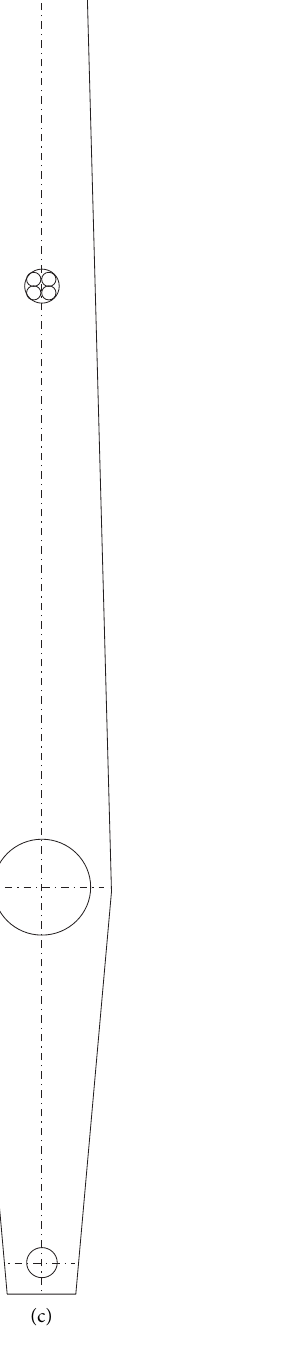
Figure 3: Composition of main load-bearing structure. (a) Main load-bearing structure. (b) A-shaped pillars. (c) Vertical